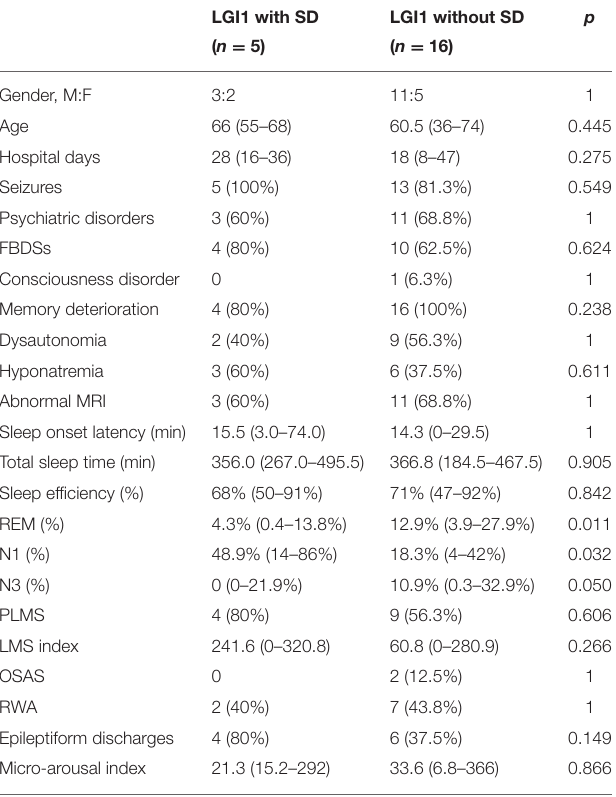
TABLE 3 | The clinical and PSG characteristics in LGI1-Ab encephalitis with status dissociatus (SD) and without SD. LGI1 with